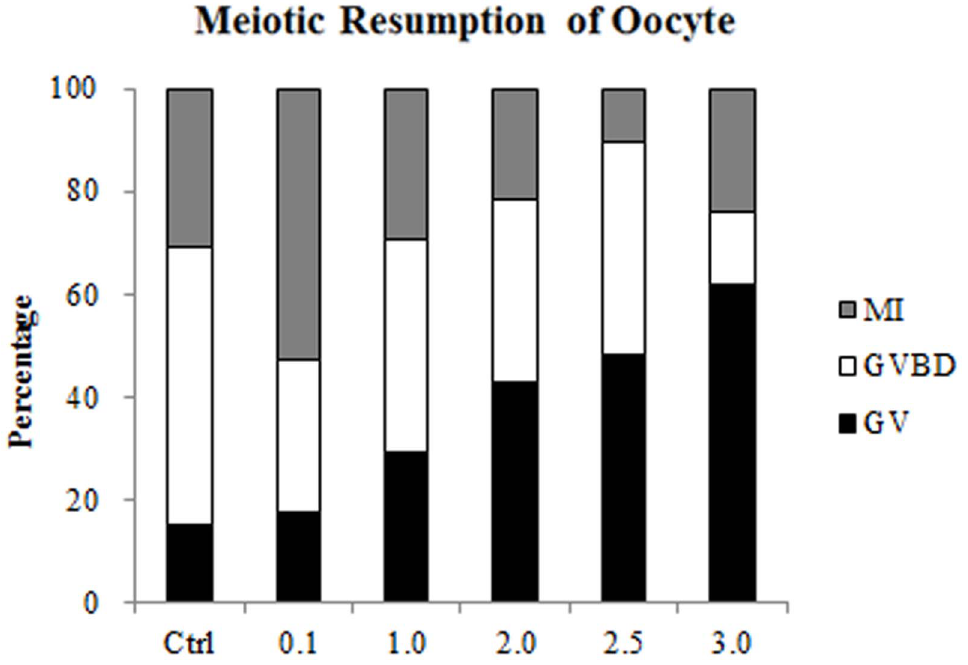
Figure 2. Effects of different concentrations of TPEN on meiotic resumption in porcine oocytes. Nuclear distribution was assessed after 25 h of IVM and treatment with various concentrations of TPEN (0, 0.1, 1.0, 2.0, 2.5, and 3.0 m M). The percentages of oocytes at the GV, GVBD, and MI stages are shown. TPEN inhibits oocyte maturation in a dose-dependent manner. Data are presented as mean values of three independent experiments. Ctrl, control group.